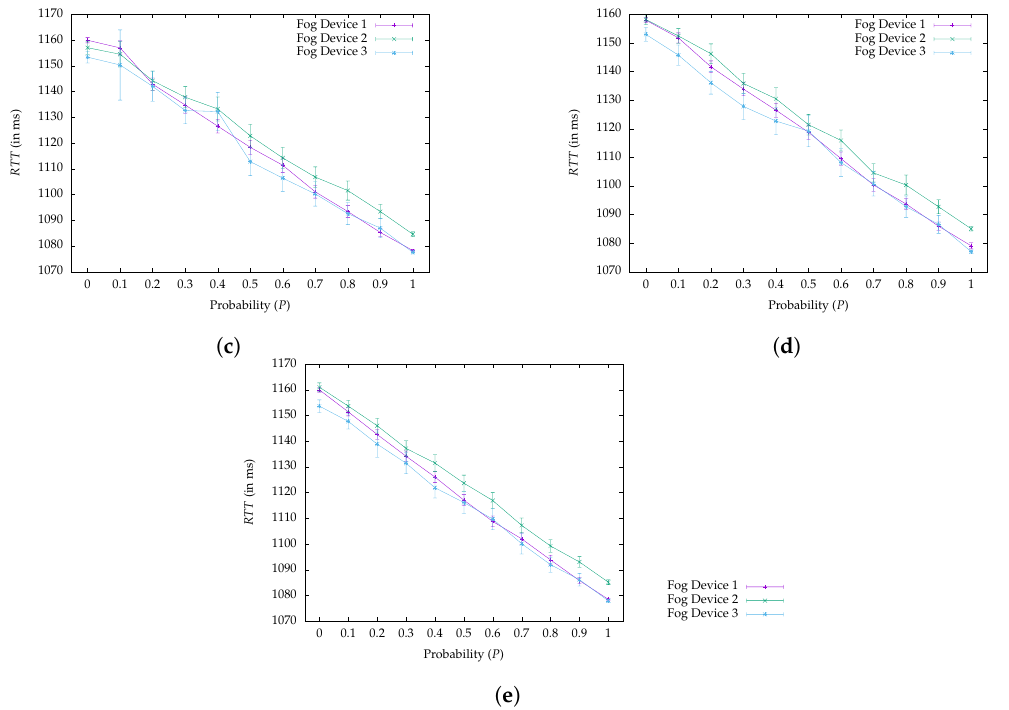
Figure 7. Experimental results of the system’s total mean RTT value, through the viewpoint of the involved fog devices. The error bars correspond to the 95% upper and lower confidence intervals. ( a ) Interval: 25,000 (in ms). ( b ) Interval: 20,000 (in ms). ( c ) Interval: 15,000 (in ms). ( d ) Interval: 10,000 (in ms). ( e ) Interval: 5000 (in ms).